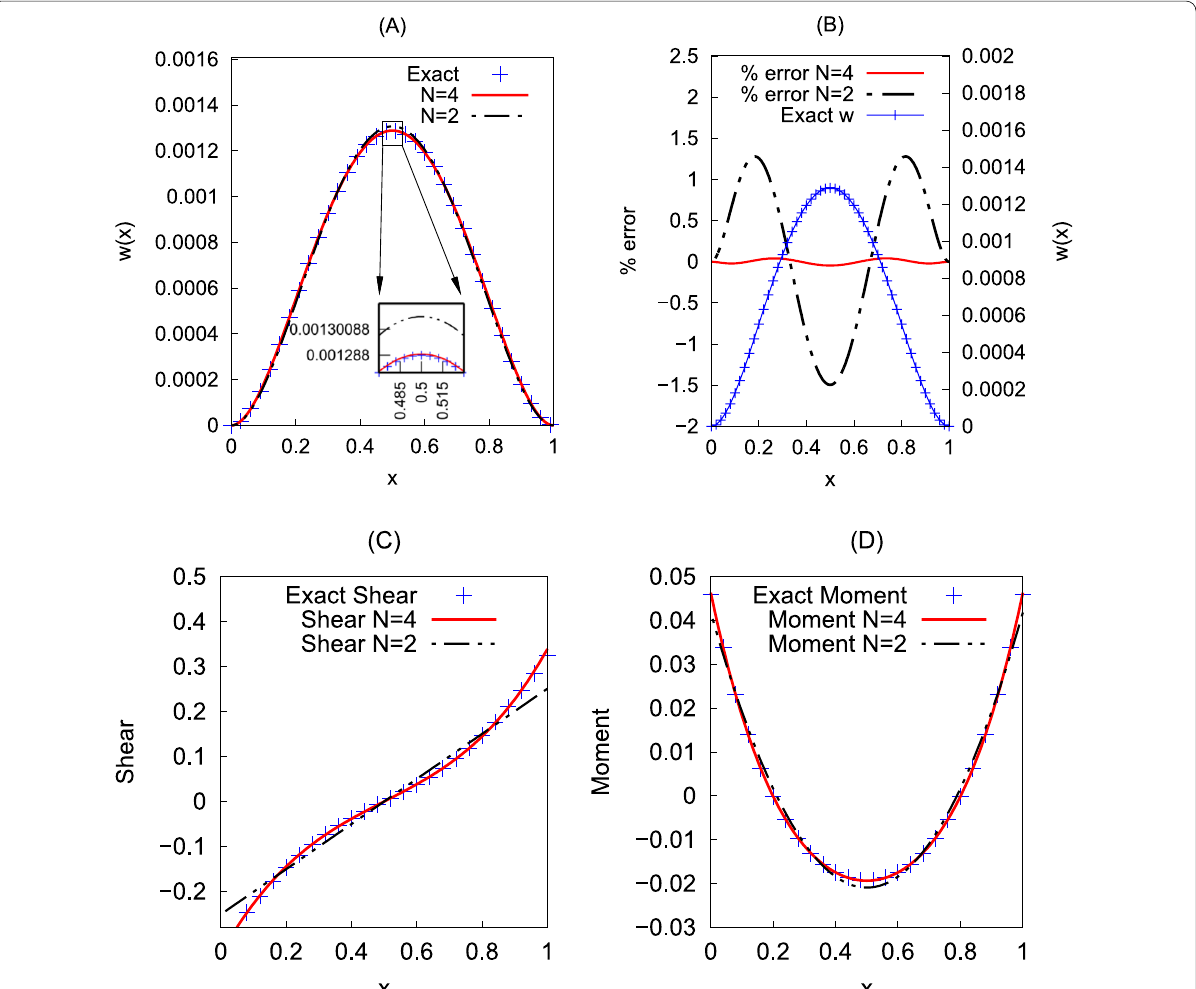
Fig. 6 Case (1) RRM and exact results. A Exact solution and RRM solutions. B Exact deflection and percentage error for various orders. C Exact and RRM shear. D Exact and RRM moment